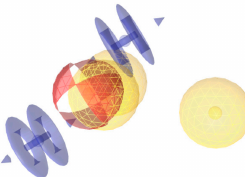
Figure 1. Refined pharmacophore of “Garg et al.” [14] dataset.